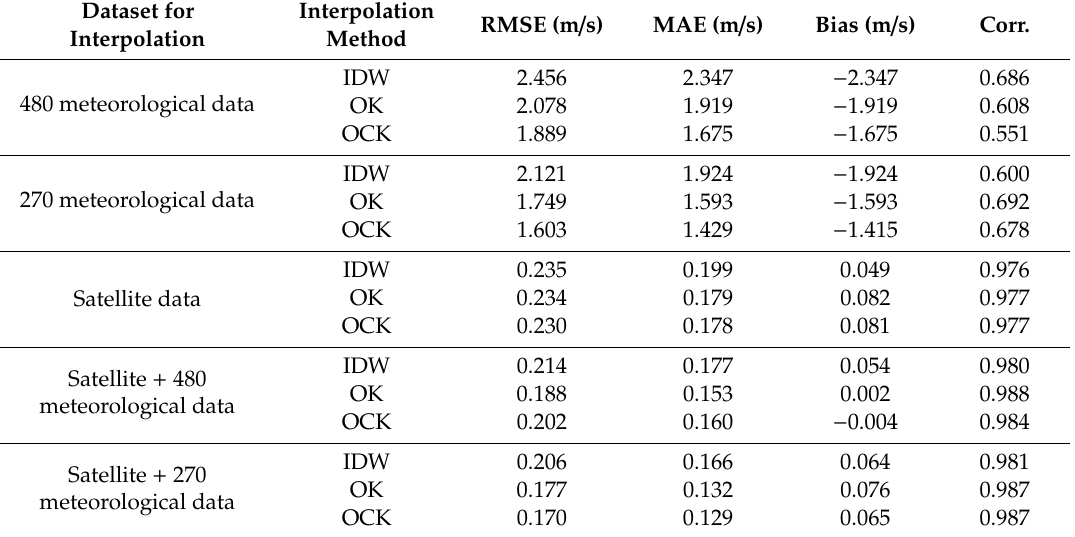
Table 2. Statistics of the comparison between buoy-derived mean wind speeds (MWS) and interpolated MWS at a height of 10